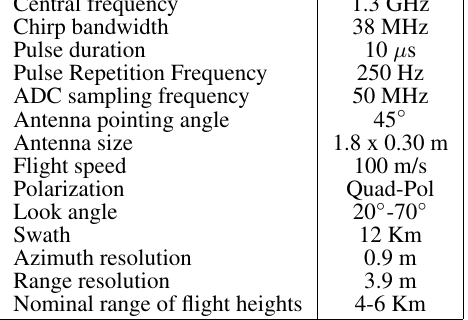
Table 1. Characteristics of the SARAT system.